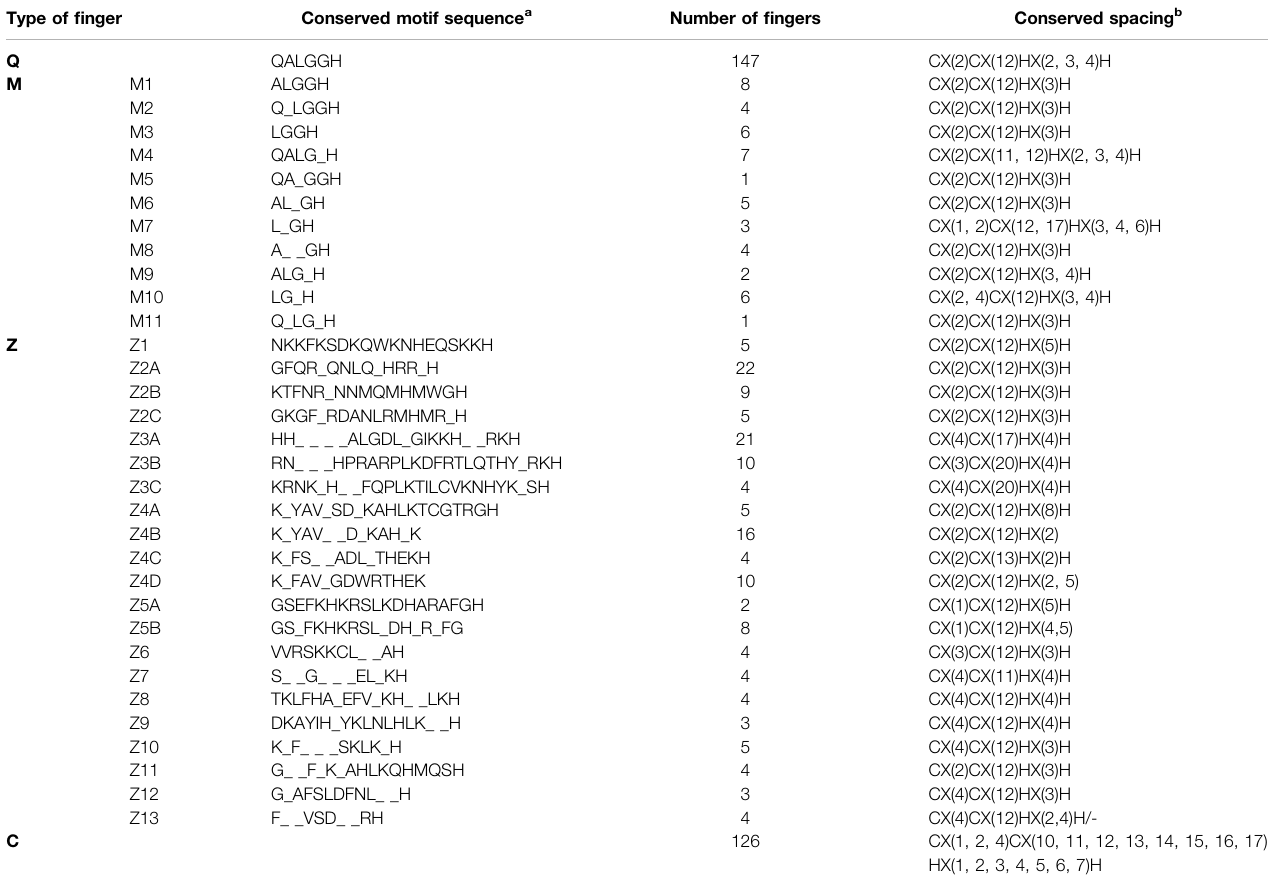
TABLE 1 | types of zinc- fi nger motifs in